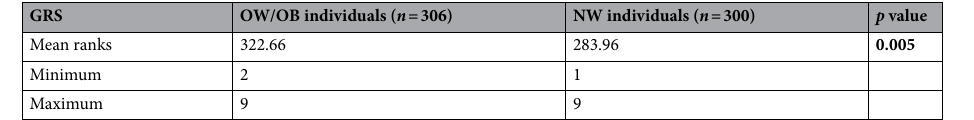
Table 2. Comparison of GRS between overweight/obese and normal-weight individuals. GRS genetic risk score, OW/OB overweight/obese, NW normal-weight. The p value for GRS was calculated by the Mann– Whitney U test. The p value was considered significant and indicated in bold when p value < 0.05.